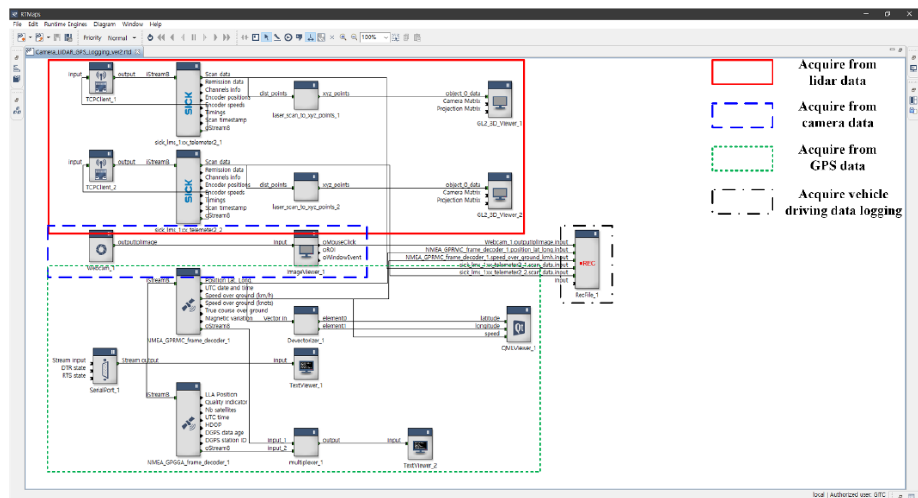
Figure 9. Data-logging system based on multiple sensors (GPS, LIDAR, and camera) using RTMap.